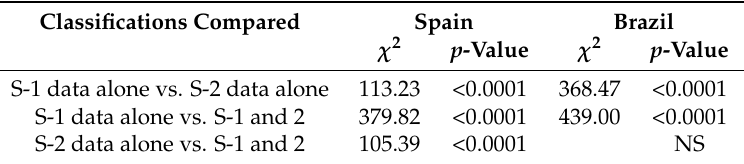
Table 5. McNemar’s χ 2 test results for the Spanish and Brazilian case studies. The χ 2 value less than 3.14 indicates that the two classifications were not significantly